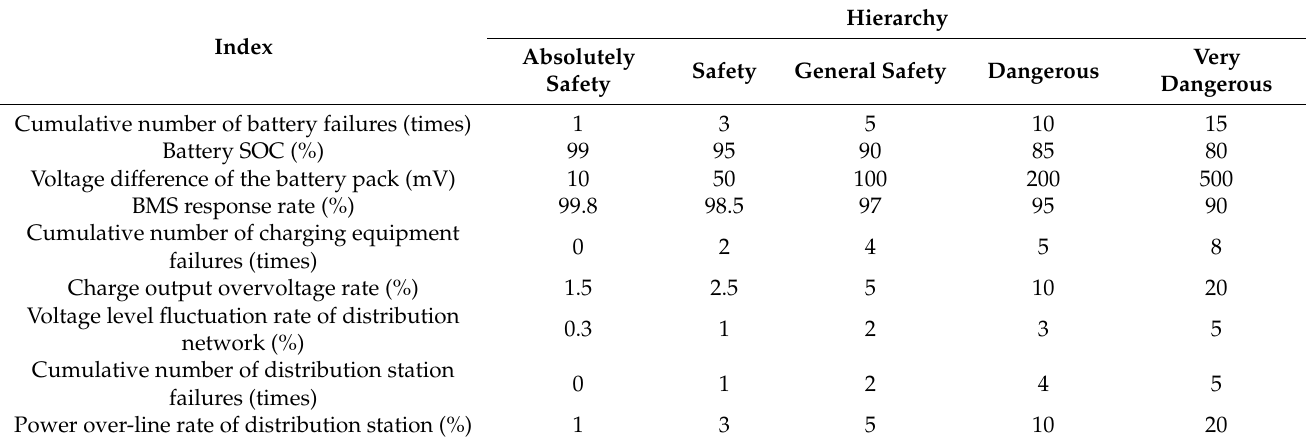
Table 3. The safety rating of the integrated safety evaluation index for charging electric